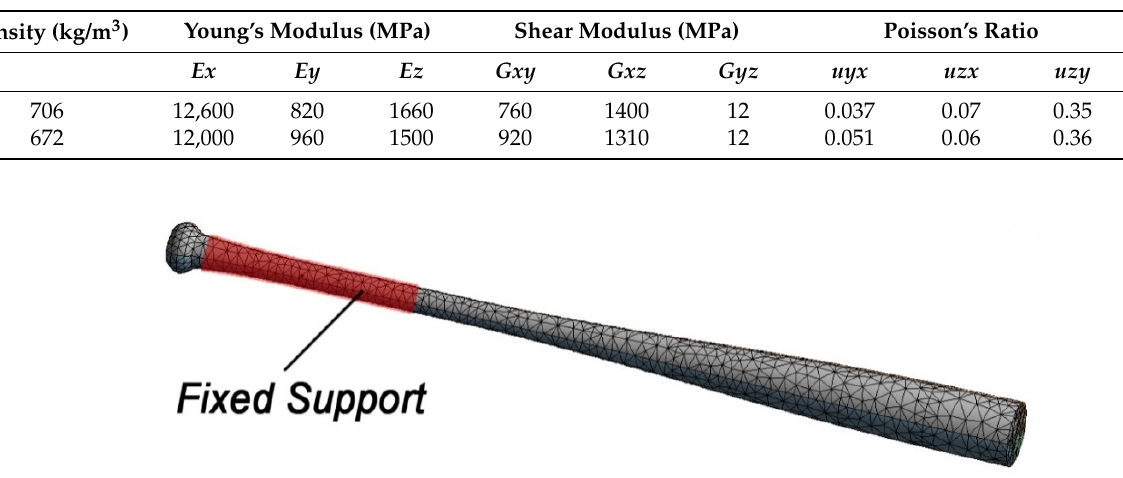
Figure 5. Mode shapes of the bat with its nodal points. Note that the nodal points (nodes) are shown in places on the bat in which the displacement is zero. After performing the modal analysis, the locations of node 1, node 2 and the COP were determined, and the root mean square distance (RMSD) was calculated. 3. Optimization of the Performance of the Baseball Bat Code was written for the ANSYS software to generate the geometry of the baseball bat, run the modal analysis to determine the location of the nodal points and COP and calculate the objective function. The length of the bat was 34 inches (864 mm), which is representative of bats used in Major League Baseball [11]. The diameter of the bat should be less than 2.61 inches (66.3 mm), and therefore, the radius of the bat should be less than 33.2 mm, as dictated by Rule 3 [8]. Hence, the design variables of the problem r i were restricted between the upper and lower bounds. The lower bounds for the design varia- bles were defined in a way to ensure that the bat could maintain its structural integrity. The allowable maximum radius of the handle at the grip section ( r 1 and r 2 ) was 20 mm so that the bat could be held by the batsman. The optimization problem of this study was defined as follows: Minimize RMSD(r i ), subject to 12𝑚𝑚 ≤ 𝑟 (cid:2869) , 𝑟 (cid:2870) , ≤ 20𝑚𝑚 12𝑚𝑚 ≤ 𝑟 (cid:2871) , 𝑟 (cid:2872) , 𝑟 (cid:2873) , 𝑟 (cid:2874) , 𝑟 (cid:2875) , 𝑟 (cid:2876) , 𝑟 (cid:2877) , 𝑟 (cid:2869)(cid:2868) ≤ 33.2𝑚𝑚 (3) The genetic algorithm optimization method (GA) was implemented to optimize the geometry of the baseball bat. Genetic algorithms are random adaptive heuristic search al- gorithms inspired by the process of Darwinian selection. They belong to a larger class of